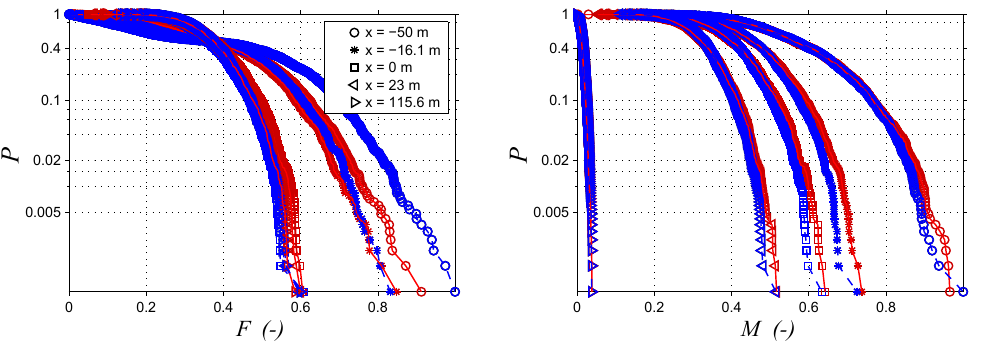
Figure 11. Probability of exceedance of the positive peaks in the time series of the sectional forces and moments for load case 1.2. Aerody- namic damping based on standard deviation of tower top displacement. The forces and moments are normalized with the largest force and moment peak at the seabed in the Flex5 calculation. Blue: Flex5. Red: QuLA.